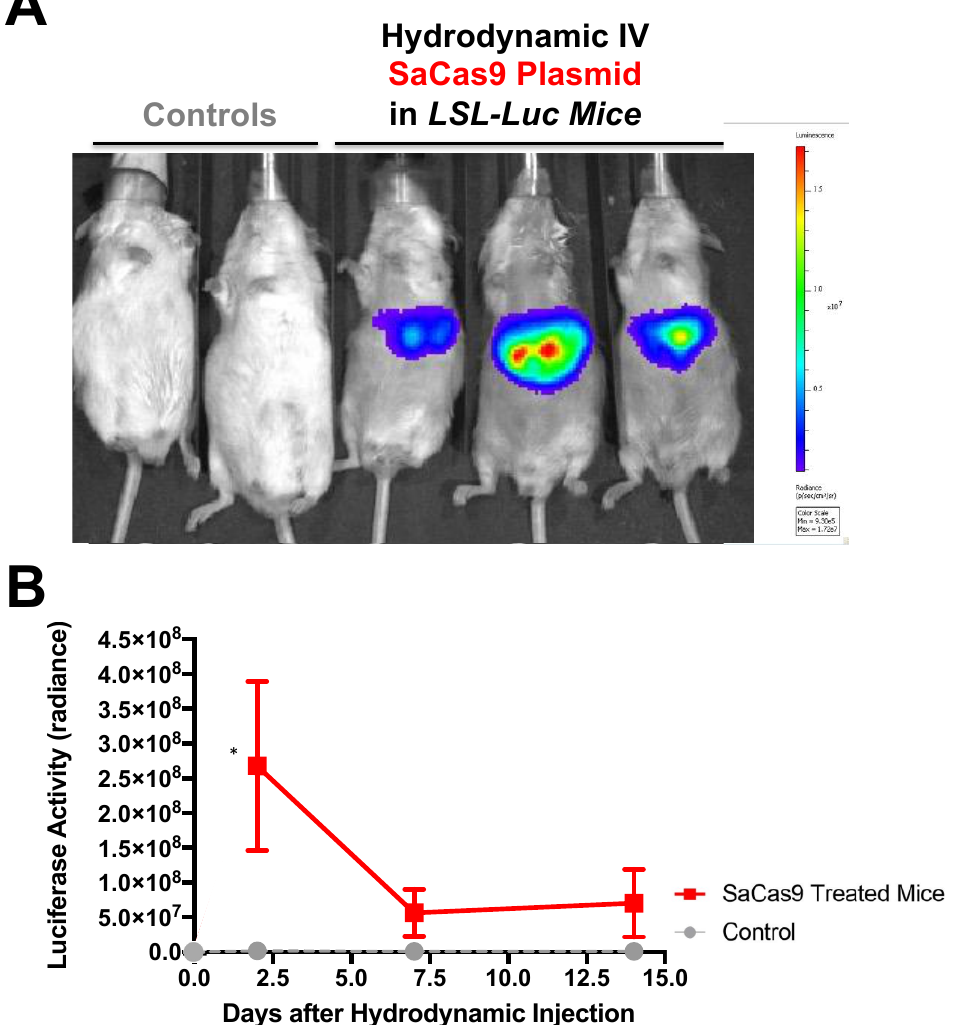
Figure 4. Hydrodynamic delivery in luciferase reporter mice. ( A ) LSL mice contain a floxed stop cassette blocking luciferase expression. Gene editing by CRISPR gene editing excises the stop cassette exposing luciferase to the promoter allowing for expression. LSL mice were injected hydrodynamically with SaCas9 gene editing plasmids. Control mice received a 2.5 mL PBS injection and the SaCas9 plasmid mice received 12.5 µg of each plasmid in the 2.5 mL of PBS. ( B ) Mice were monitored for luciferase activity on days 2, 7, and 14. Using a t-test for each day, the SaCas9-treated groups were significant compared to the control on Day 2; 95% confidence intervals are shown (n = 3) (* p <.05).